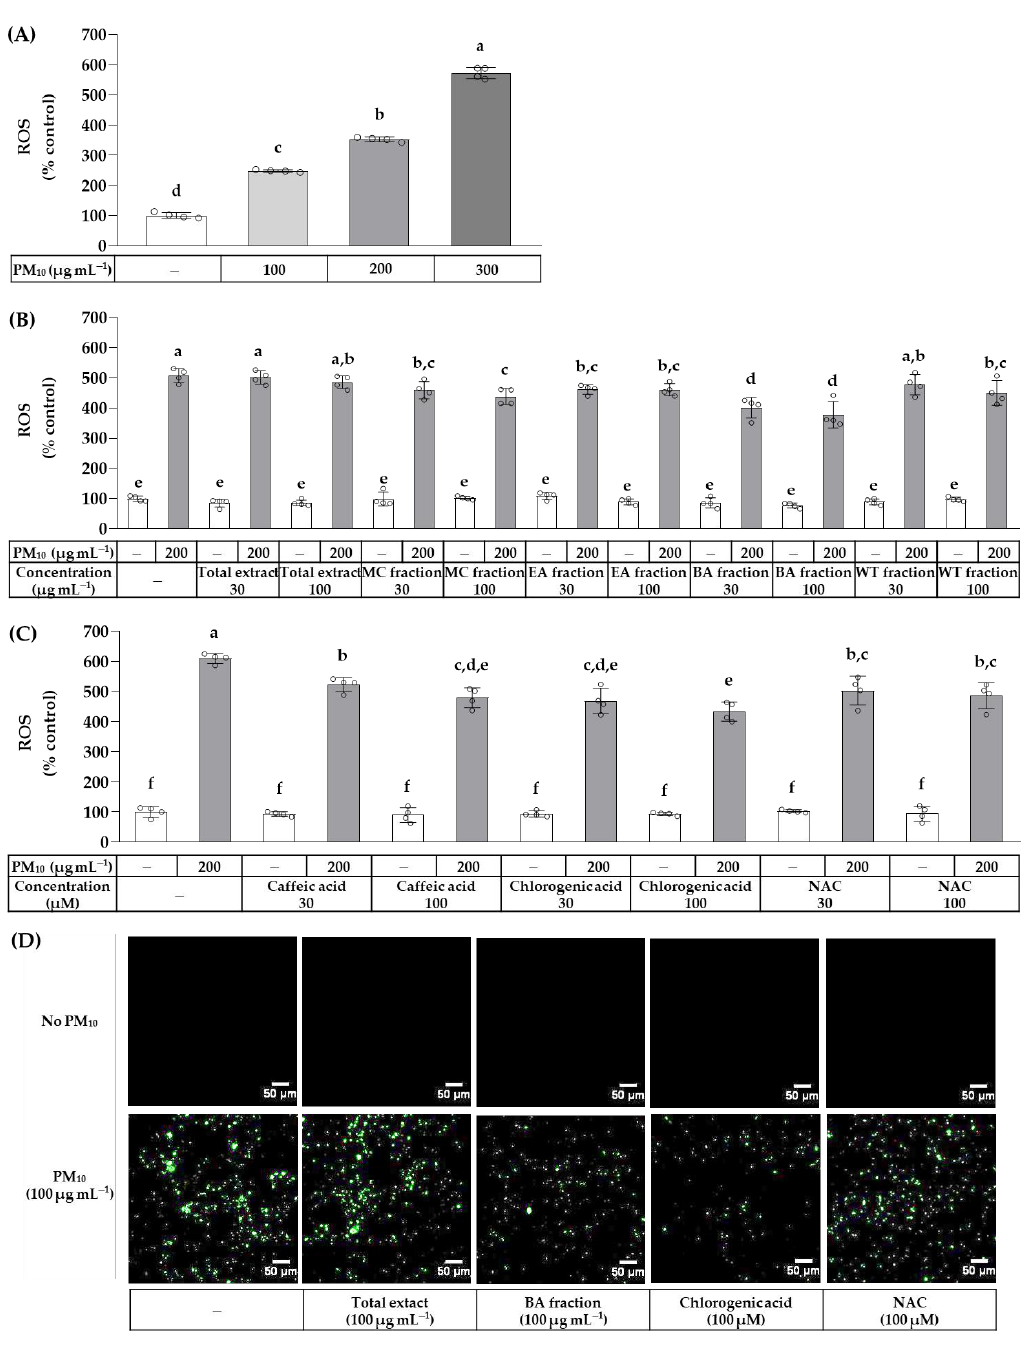
Figure 4. Effects of the total OJ extract, its solvent fractions, chlorogenic acid, caffeic acid, and NAC on the production of reactive oxygen species (ROS) in HaCaT keratinocytes exposed to PM 10 . In ( A ), after pre-labeling with 2’,7’-dichlorodihydrofluorescein diacetate (DCFH-DA) for 30 min, cells were treated with PM 10 at different concentrations for 60 min. In ( B , C ), the pre-labeled cells were treated with the total OJ extract, its solvent fractions, or compounds at the specified concentrations, alone or in combination with PM 10 (200 μg mL −1 ), for 60 min. Typical images of cells fluorescing due to ROS production are shown in ( D ). The change in the fluorescence intensity due to cellular ROS production was determined. Data are presented as mean ± SD ( n = 4). Groups that do not have the same lowercase alphabet letters (a–f) are considered to have significantly different means at the p < 0.05